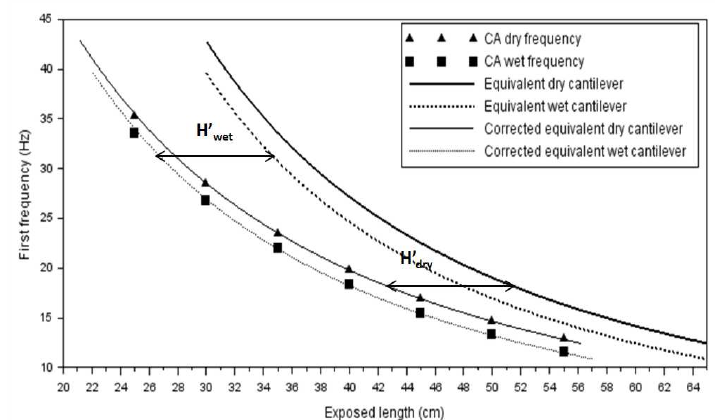
Figure 13. Equivalent cantilever of the circular rod in dry and wet conditions